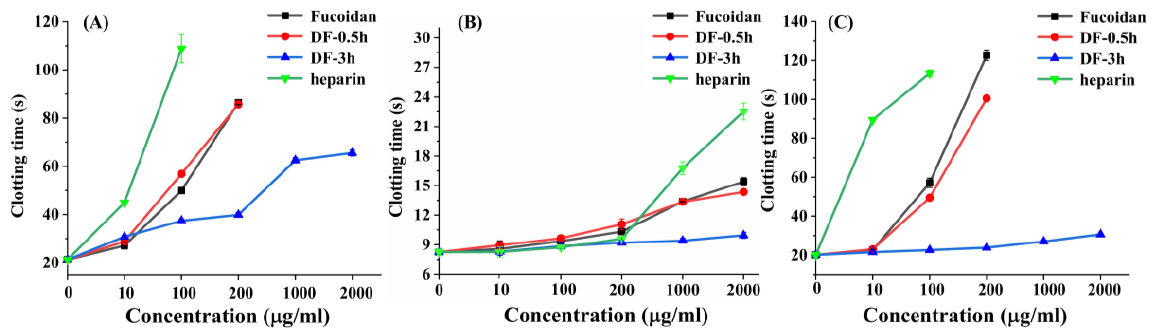
Figure 6. Comparison of the activated partial thromboplastin time ( A ), prothrombin time ( B ) and thrombin time ( C ) of the degradation products (DF-0.5 and DF-3) with those of fucoidan and heparin (n = 4).